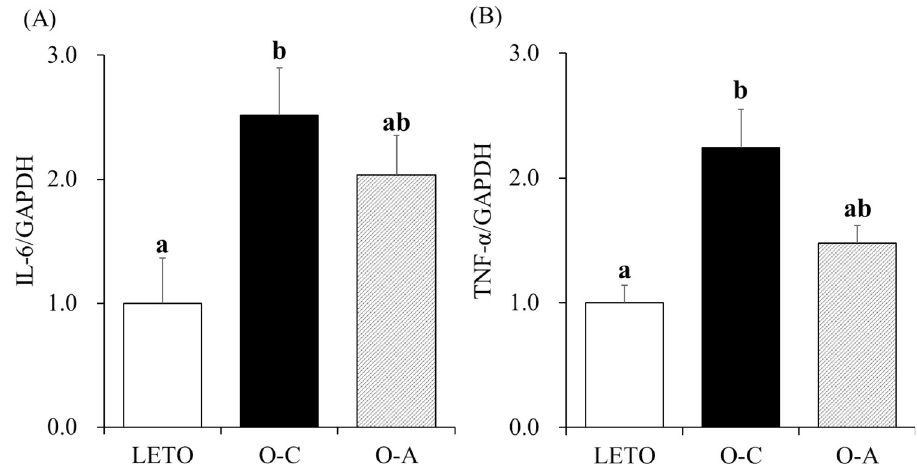
Fig 3. Effects of D -allulose on renal mRNA levels of proinflammatory cytokines. (A) mRNA levels of interleukin-6 (IL-6). (B) mRNA levels of tumor necrosis factor- α (TNF- α ). The data are presented as mean ± standard error (SE) (n = 10 for OLETF rats and n = 6 for LETO rats). ab Different letters in the same column indicate statistical difference, P < 0.05, Tukey’s multiple comparison test. GAPDH, Glyceraldehyde 3-phosphate dehydrogenase; LETO, Long-Evans Tokushima Otsuka; OLETF, Otsuka Long-Evans Tokushima fatty; O-C, OLETF control; O-A, OLETF D -allulose.